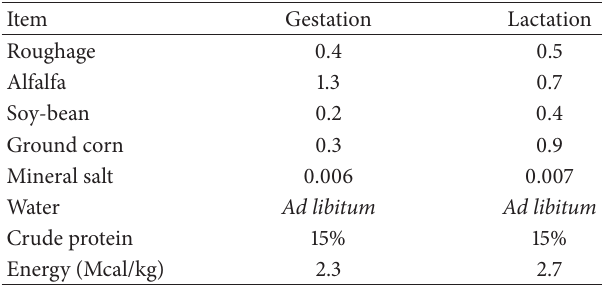
Table 1: Diet supplied to ewes during experimental period